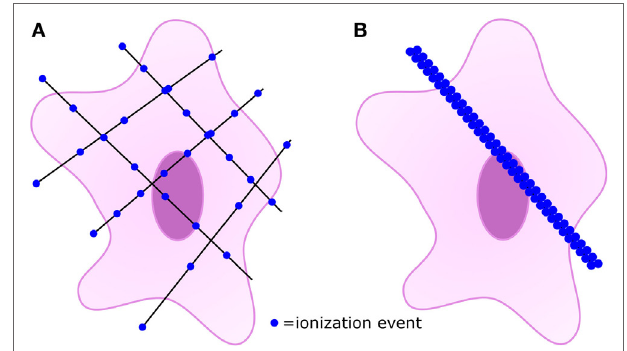
FiGURe 2 | The main factor differentiating low-linear energy transfer (LET) and high-LET therapies is the amount of ionization along the path of the beam. (A) Low-LET radiation is sparely ionizing, and multiple exposures may be used to adequately irradiation target tissues. (B) High-LET radiation causes dense ionization along the course of the